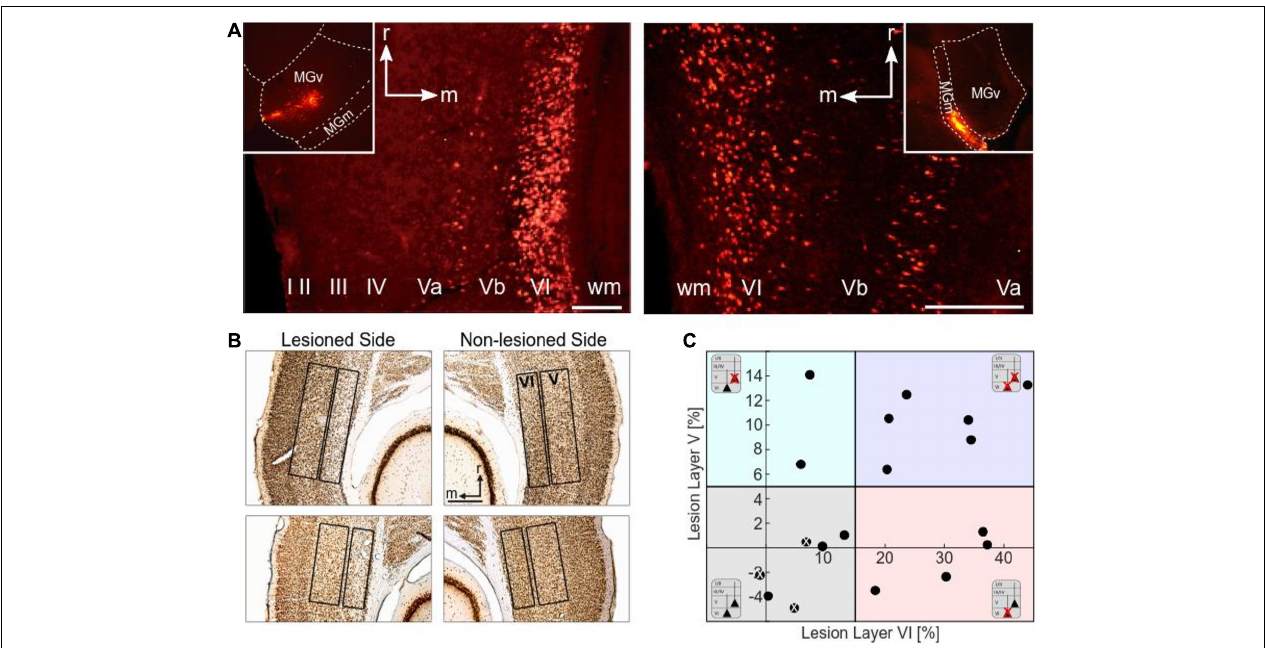
FIGURE 2 | Histological analysis. (A) Retrograde labeling of CT neurons. Images by fluorescence microscopy show examples of injection sites into the MGv (left inset) and MGm (right inset) of the MGB, and the corresponding retrograde labeling in layers VI and V of the ACx (field AI). MGv receives cortical input mainly from layer VI, but also from layer V. Cortical neurons from layers VI and V project to MGm. Scale bars: 200 µ m (A left), 100 µ m (A right). (B) Histological analysis of neuronal loss of the animals used for CSD analysis. Top: NeuN-stained section showing neuronal apoptosis in layer VI of the ipsilateral, i.e., illuminated cortical side of AI (case G12). Cellular density is much lower than in the contralateral non-lesioned side. Bottom: NeuN-stained section showing neuronal apoptosis in layers V and VI of the illuminated cortical hemisphere in another case (G13). Lesions in layer V were not as strong and not as clearly visible as layer VI lesions. Scale bar: 500 µ m. (C) Scatter plot representing the percentage neuronal loss (positive values) compared to the contralateral side in layers V and VI of the individual animals (negative values result from statistical variance around mean). There is no correlation between lesion strengths in layers V and VI ( r = 0.394, p = 0.106). The different background colors represent the ranges of the four lesion groups to which the cases were assigned according to their lesion strengths in layers V and VI. Animals injected with saline instead of the tracer are labeled with a white